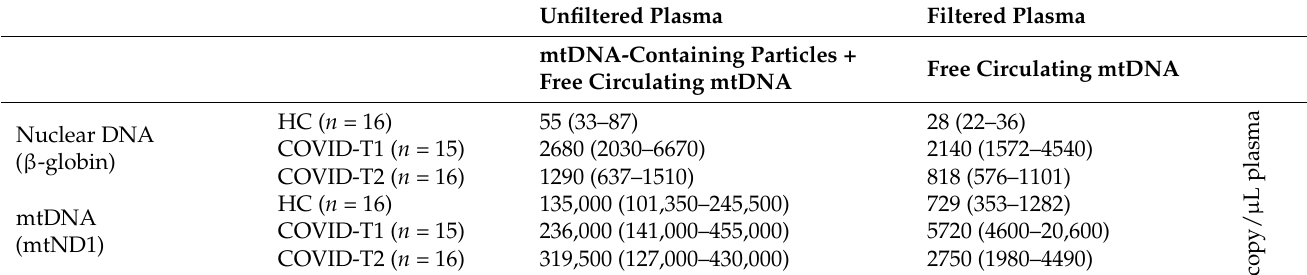
Table 2. Plasma amount of nuclear DNA ( β -globin) and mitochondrial DNA (mtDNA) in HC = healthy controls, COVID-T1, and COVID-T2 groups before and after filtration. Filtered mtND1. ( n = 15–16). Values are displayed as median